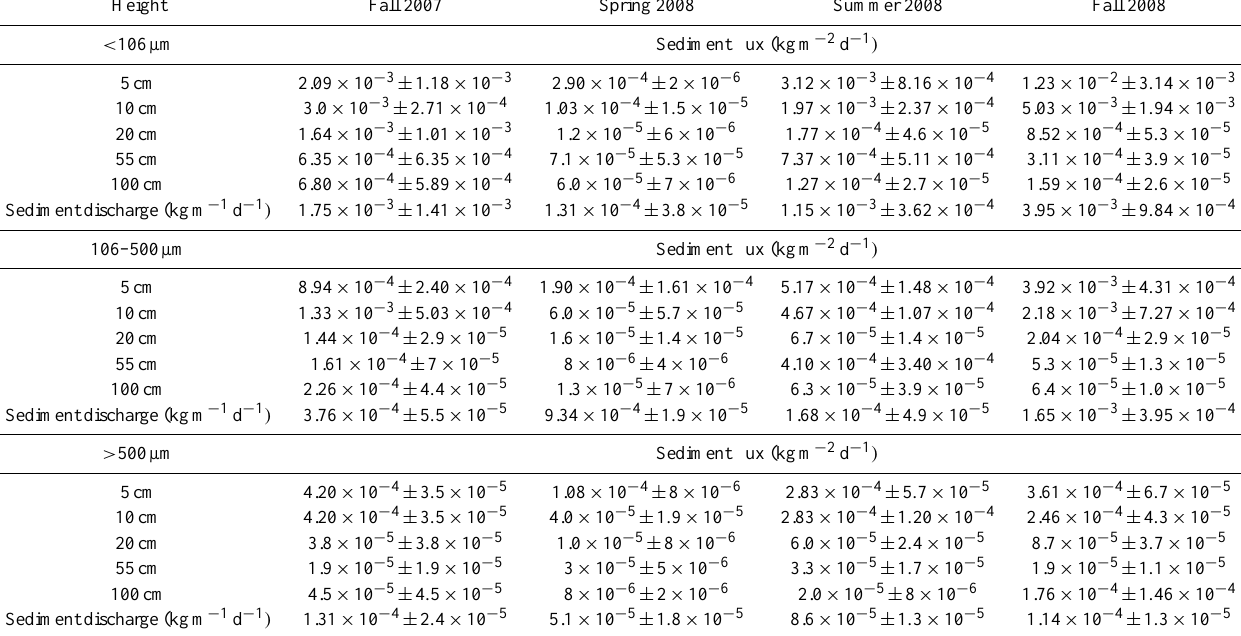
Table C1. Mean ( ± SE) sediment flux (kgm − 2 d − 1 ) and sediment discharge (kgm − 1 d − 1 ) for different size classes of sediment in the unburned